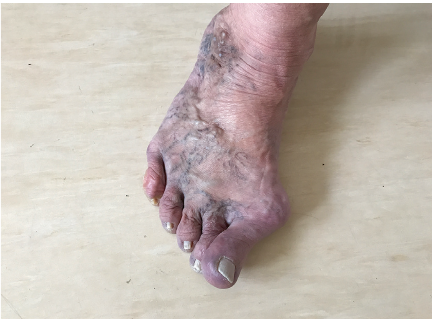
Figure 1: Hallux valgus and subluxation of the proximal interphalangeal (PIP) joint of the toes, varicose veins, and paperlike skin in our patient.